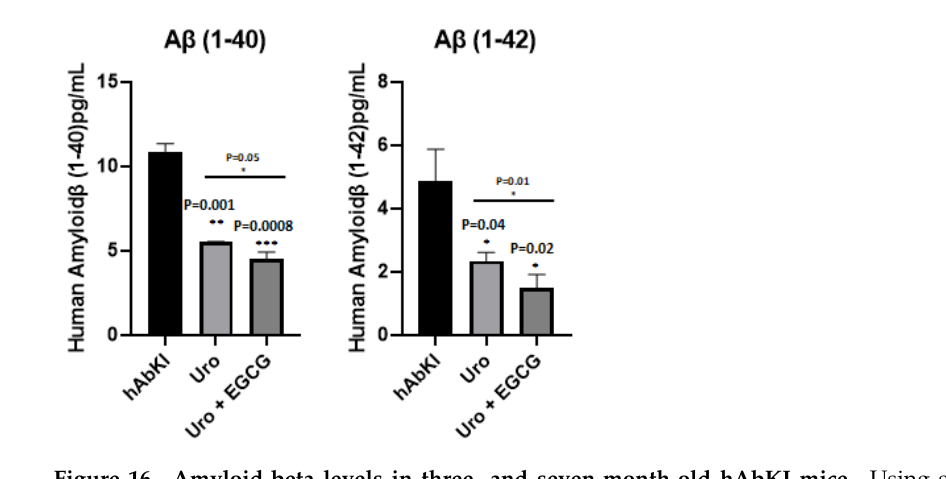
Figure 16. Amyloid-beta levels in three- and seven-month-old hAbKI mice. Using sandwich ELISA kit (IBL), we measured soluble A β 1–40 and 1–42 levels in seven-month-old homozygous hAbKI mice and treated hAbKI mice with Urolithin A and EGCG. Both A β 40 and A β 42 levels were progressively decreased in treated hAbKI mice with Urolithin A and EGCG.